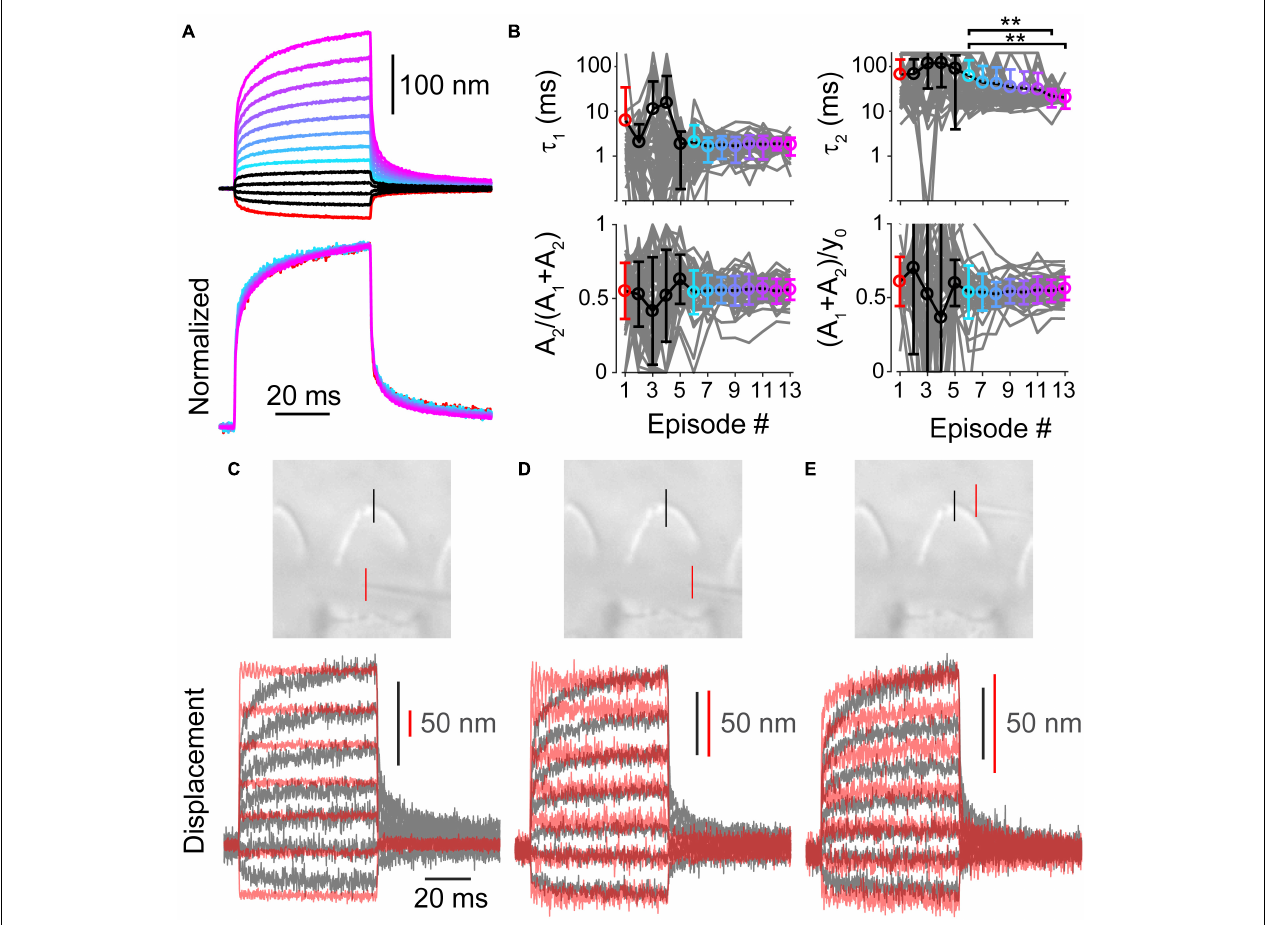
FIGURE 6 | (A) Average of all measured displacements and below are those traces normalized to the end of 50 ms force step ( n = 47). Episode number color coded according to panel (B) . Only episodes 1 and 6–13 are shown for the normalized traces, others are omitted due to low signal to noise. (B) Fit parameters for creep vs. stimulation episode number with 1 mM BAPTA intracellular buffer in OHCs. Each cell is plotted in gray with mean ± standard deviation. Tukey-Kramer post hoc analysis on τ 2 showed significance for only the comparisons shown; ** p < 0.01. (C–E) Force measurements around the hair bundle indicate that the hair bundle creep is not due to fluid jet anomalies. (C) Image of the fiber and hair bundle stimulated by a fluid jet is shown with locations of motion measurement indicated by colored lines. Measured bundle (black) and fiber (red) displacement is plotted below. Resonance observed in the fiber motion was likely due to the vibration of the fluid-jet pipette observed with larger stimulations. (D) Shows force out of the fluid jet was square as indicated by the fiber motion in front of the hair bundle toward the side. (E) Motion of the of fiber and bundle when the fiber was located behind the hair bundle is shown. When the fiber was behind the hair bundle side, the bundle blocked the flow causing a slower fiber onset similar to the hair bundle